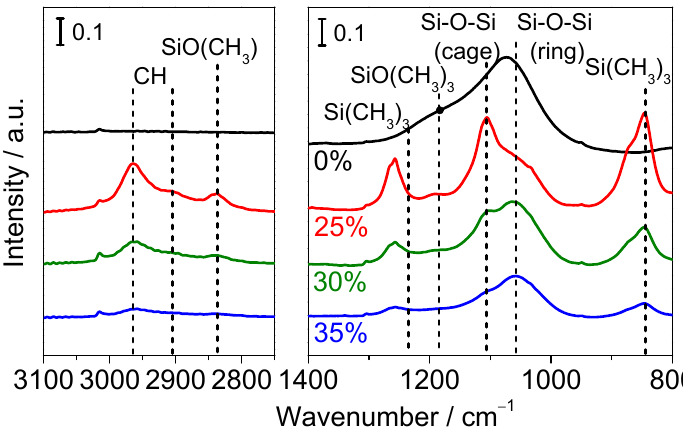
Figure 9. In situ Fourier transform infrared (FTIR) spectra (after 30 min deposition).